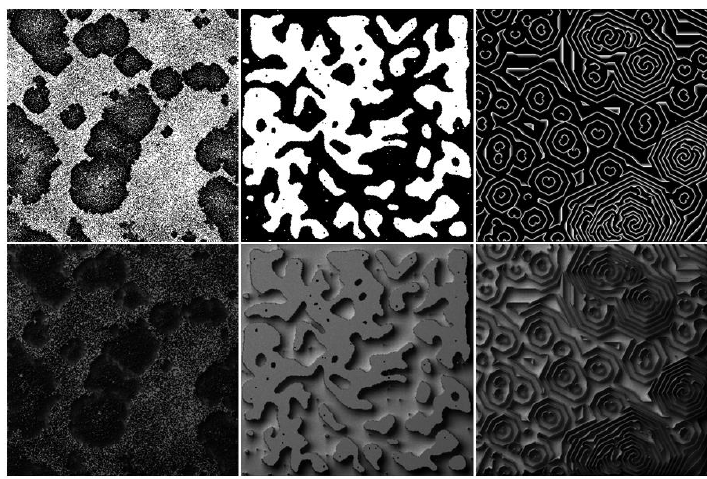
Figure 2. Textures generated with cellular automata. Upper left: Texture generated with the forest fire model. Bottom left: Relighting result. Upper middle: Texture generated with the surface tension model. Bottom middle: Relighting result. Upper right: Texture generated with the excitable media model. Bottom right: Relighting